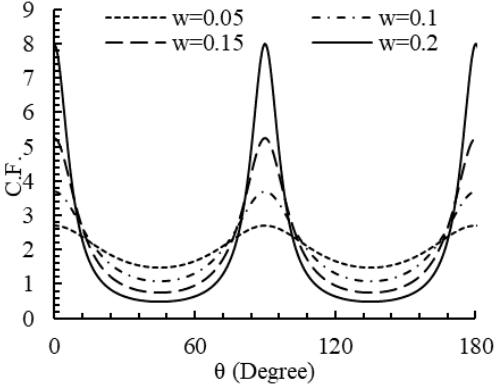
Figure 16. Distribution of the cost function around square cutout in an optimal state (equibiaxial